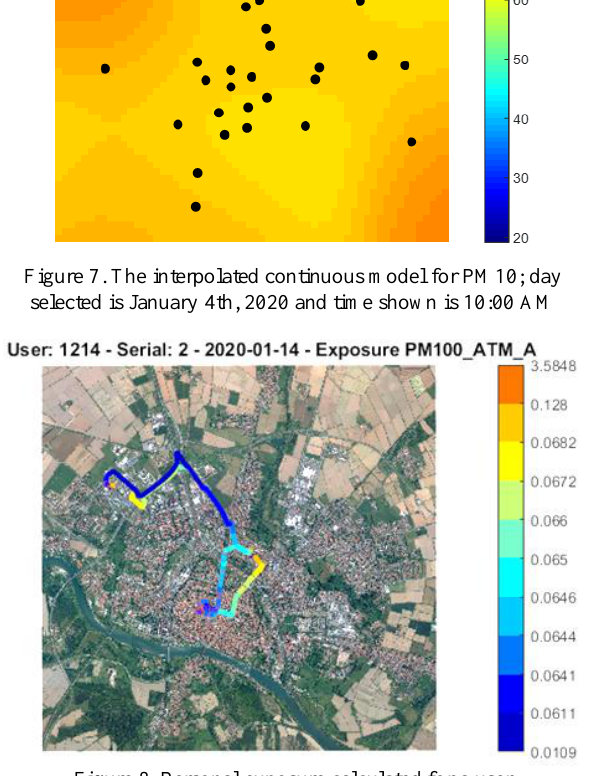
Figure 8. Personal exposure calculated for a user